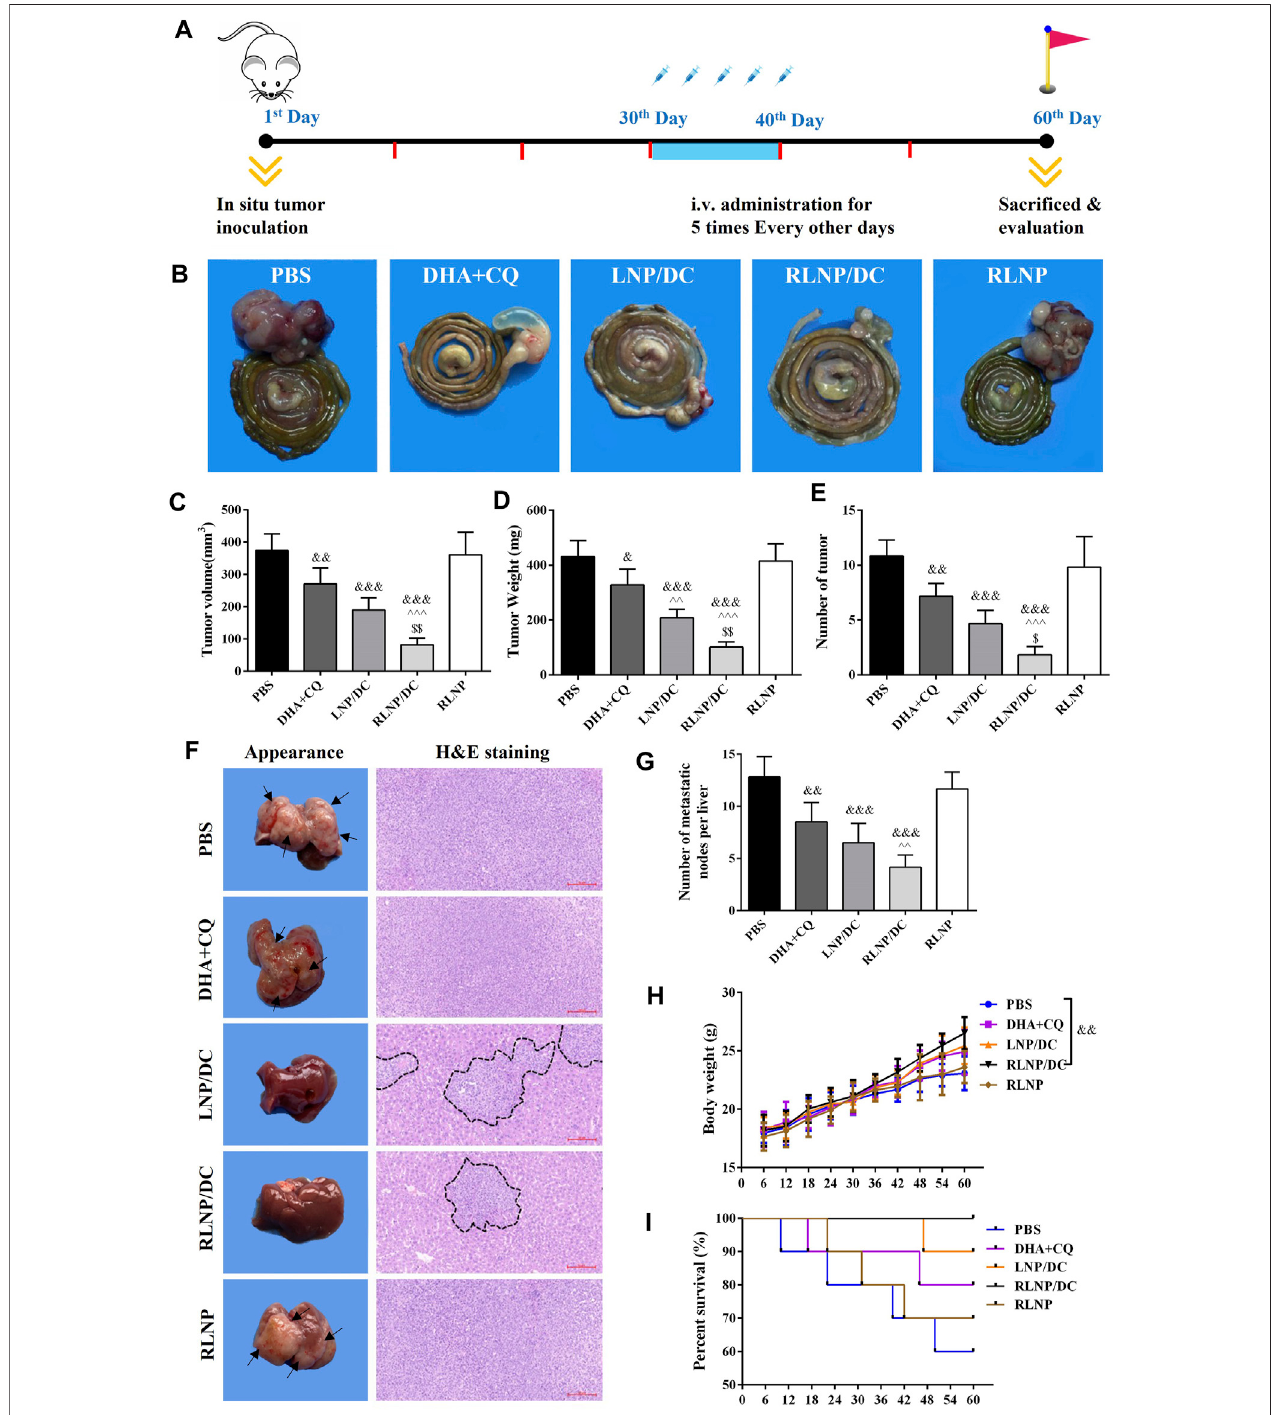
FIGURE 7 | Evaluation of in vivo anti-proliferation and anti-metastasis effects in a mouse model of orthotopic metastasis of colorectal cancer. (A) Schematic illustration of in vivo experiments involving therapeutic regimen. (B) Representative images of colorectum from each group. (C – E) Measurement of tumor volume (C) , tumor weight (D) , and number of tumor (E) on day 60. (F) Representative images of liver and H and E staining ( × 200) of metastatic tissue section from each group. Arrowheads indicate the metastatic nodes on the appearance ofliver and black imaginary lines mark the contractible margin ofmetastasis nodes. (G) Quantitation of the number of metastatic nodes on liver. (H) Body weight of the nude mice. (I) Survival rate of mice from each group. Each bar represents the mean ± SD ( n ≥ 6). & p < 0.05, && p < 0.01, and &&& p < 0.001 vs. Ctrl; ^^ p < 0.01 and ^^^^ p < 0.001 vs. DHA + CQ; $ p < 0.05 and $$ p < 0.01 vs. LNP/DC.